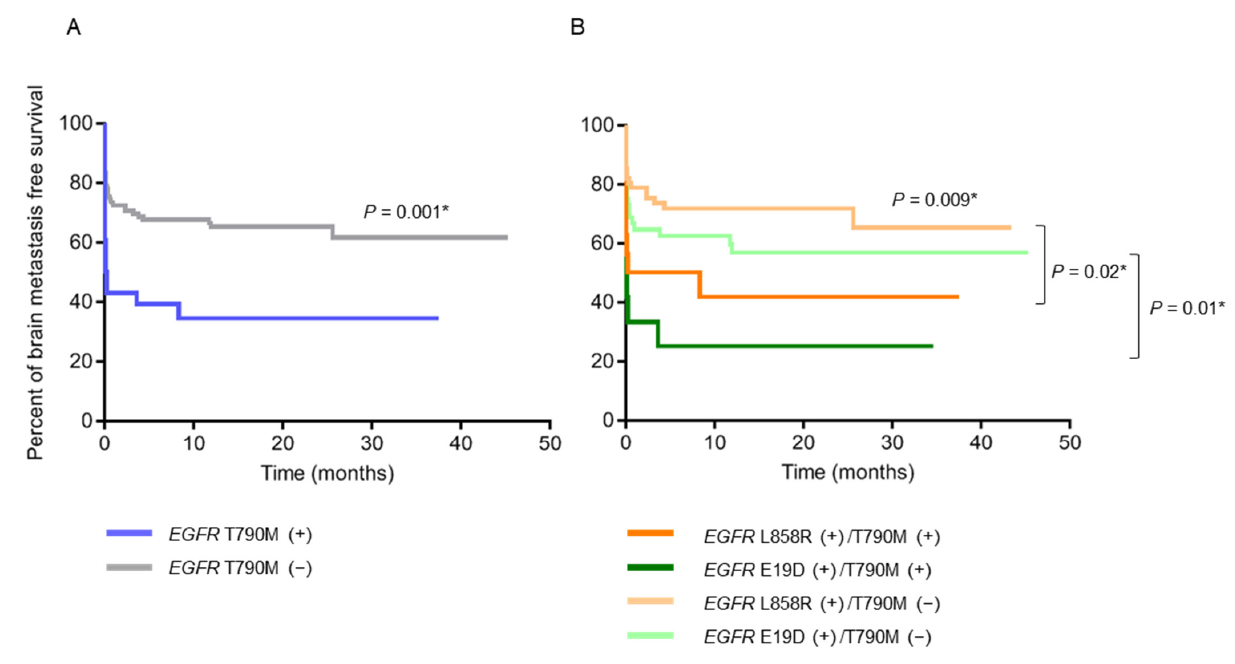
Figure 2. Brain metastasis-free survival (BMFS) analysis (N = 137). ( A ) BMFS curves of patients with pre-treatment EGFR T790M (+) (N = 28) and ( − ) (N = 109). ( B ) BMFS curves of patients with pre-